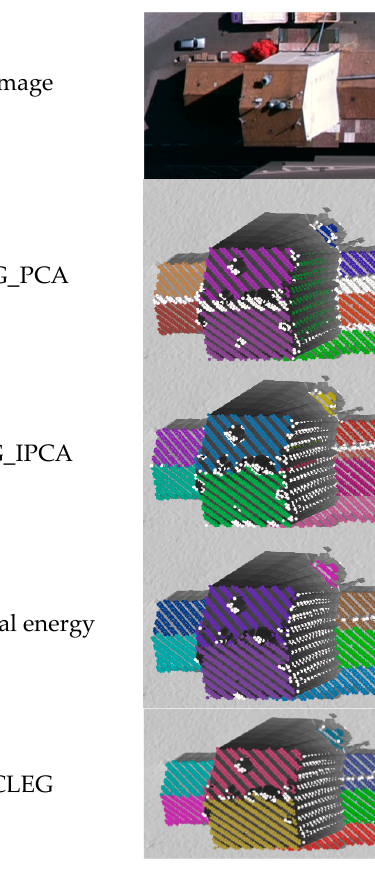
Figure 11. Disadvantage of the proposed method.